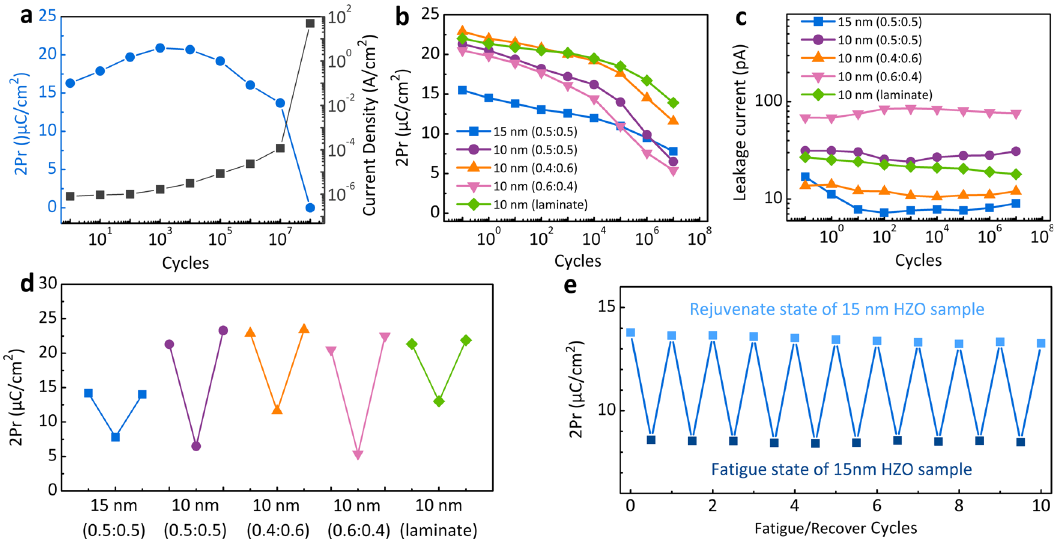
Fig. 2 Electrical measurement results of different TiN/HZO/TiN devices: 15-nm-thick Hf 0.5 Zr 0.5 O 2 , 10-nm-thick Hf 0.5 Zr 0.5 O 2 , 10-nm-thick Hf 0.4 Zr 0.6 O 2 , 10-nm-thick Hf 0.6 Zr 0.4 O 2 , and the nanolaminated 10-nm-thick Hf 0.5 Zr 0.5 O 2 fi lms. a The 2 P r of 15-nm-thick Hf 0.5 Zr 0.5 O 2 device measured by ±3 V P – V loop and the corresponding leakage currents measured at 2 V, as a function of switching cycles, which was performed by applying bipolar voltage pulses of ±5 V at f = 500 kHz. b The trend of 2 P r changes of different devices with the switching cycles at a low fi eld of ±1.8 MV/cm. c The corresponding leakage current changes with the cycles. d The rejuvenation process of different devices by applying fi eld pulses of ±3 MV/cm. e Ten cycles of fatigue/rejuvenation process on the 15-nm-thick Hf 0.5 Zr 0.5 O 2 device under ±2.2V, 5 × 10 6 bipolar pulses for fatigue and ±4.0 V, 1 × 10 4 bipolar pulses for